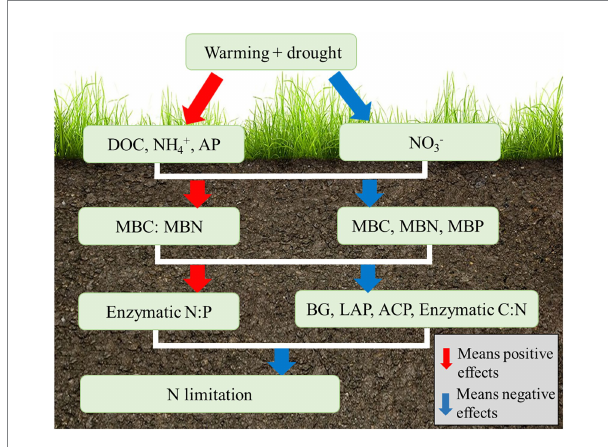
FIGURE 6 The conceptual map of warming and drought affecting the alpine meadow on the